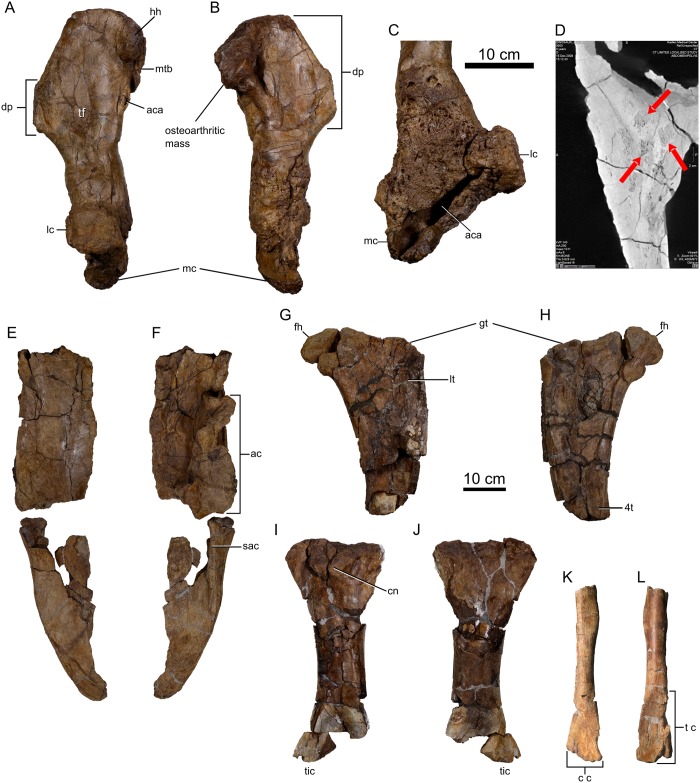
Appendicular elements of Spiclypeus shipporum gen et sp. nov. (CMN 57081).Left humerus in dorsal (A) and ventral (B) views; (C) detail of osteomyelitic infection at distal end of humerus; (D) CT image of distal left humerus showing bony sequestra (indicated by red arrows); left ilium in dorsal (E) and ventral (F) views; left femur in anterior (G) and posterior (H) views; left tibia in anterior (I) and posterior (J) views; left fibula in anterior (K) and posterior (L) views.